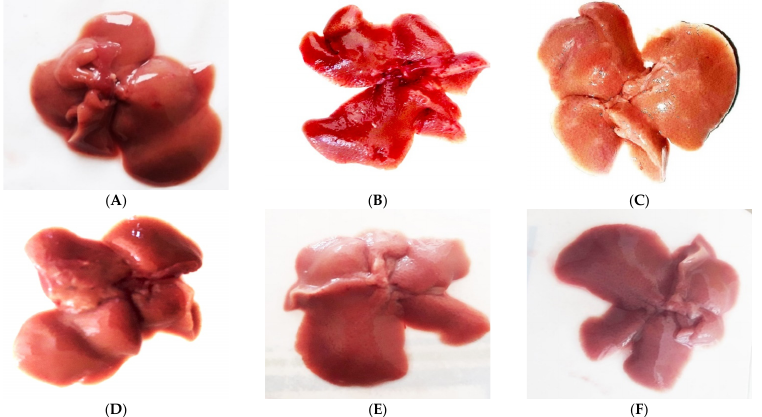
Figure 4. Liver morphology after MSCs transplantation along with compounds: ( A ) normal, ( B ) CCl 4 ‐ treated, ( C ) MSCs ‐ treated, ( D ) MSCs + compounds ( 18 ), ( E ) MSCs + compounds ( 14 ), (F ) MSCs + compounds ( 10 ). Liver morphology showed that fibrosis was greatly reduced in MSCs + com ‐ pound ( 10 ) ‐ treated experimental model, with less scars and a radish color, resembling with normal liver. 2.2.2. Homing of Transplanted MSCs in Fibrotic Liver The MSCs were labeled with PKH67 (green cell ‐ linker dye) and, for the examination of nuclei DAPI, were transplanted into the liver of a fibrotic rat model along with com ‐ pounds or in the absence of compounds for the detection of the homing of MSCs. The improved homing in fibrotic liver of the models subjected to MSCs + compounds (Figure 5A–D) treatment was examined, as shown by the high number of PKH ‐ 67/DAPI co ‐ labelled cells, compared to MSCs, that were only transplanted in the liver, thus showing an increase in the homing and engraftment of MSCs in fibrotic livers treated with MSCs along with compound ( 10 ).